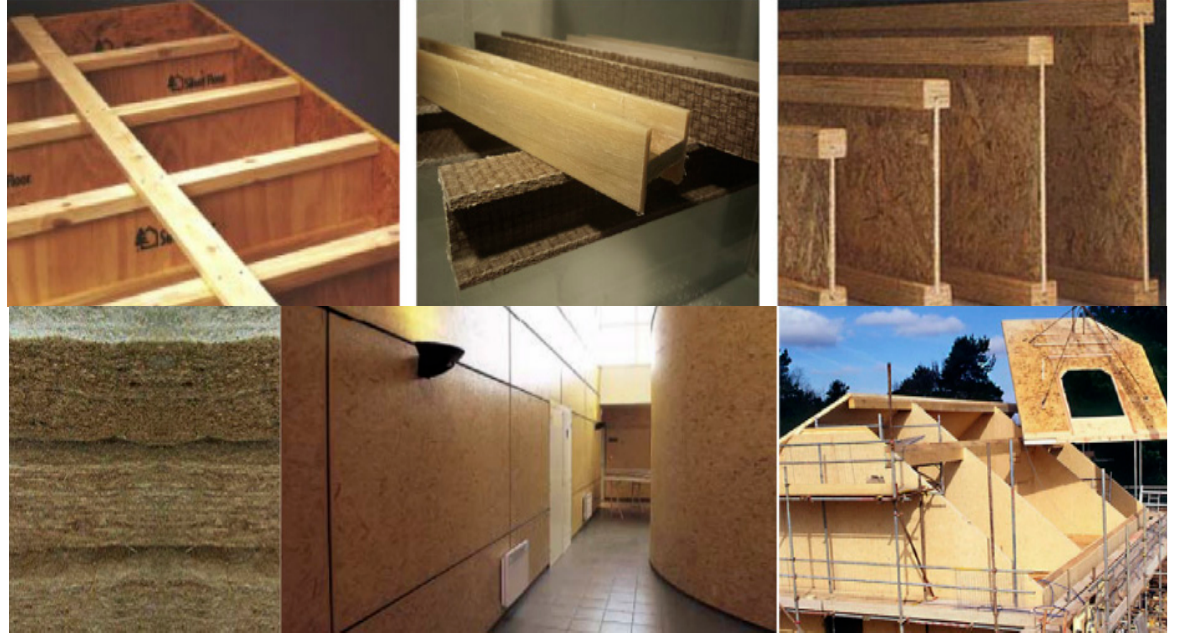
Figure 6. Construction components made NFRCs [181]. Reprinted with permission. Copyright 2020 Elsevier.